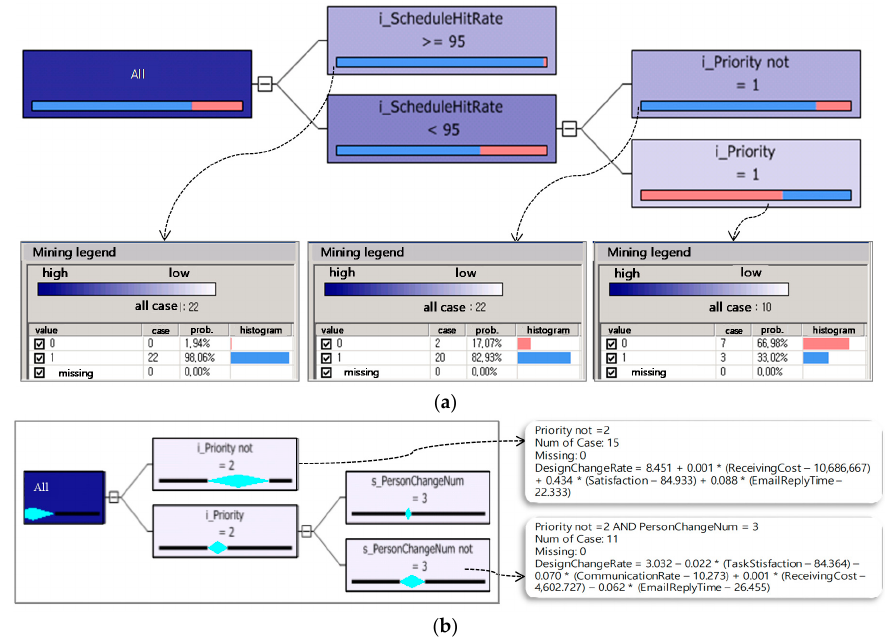
Figure 6. Two examples of data-oriented analytics using PRANAS with Microsoft SQL Server BIDS. ( a ) Classification model for on-time delivery based on decision tree; ( b ) Regression model for design change rate based on linear regression.